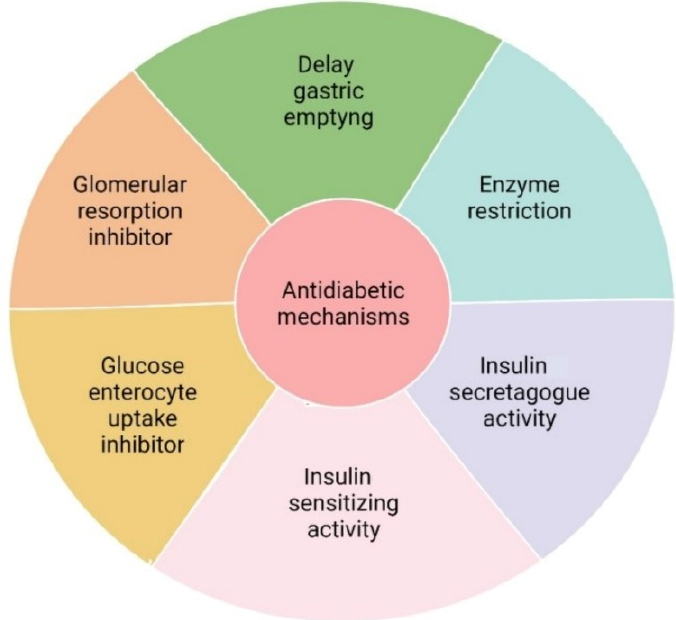
Figure 2. Primary mechanisms of action that are considered for the study of hypoglycemic activity.